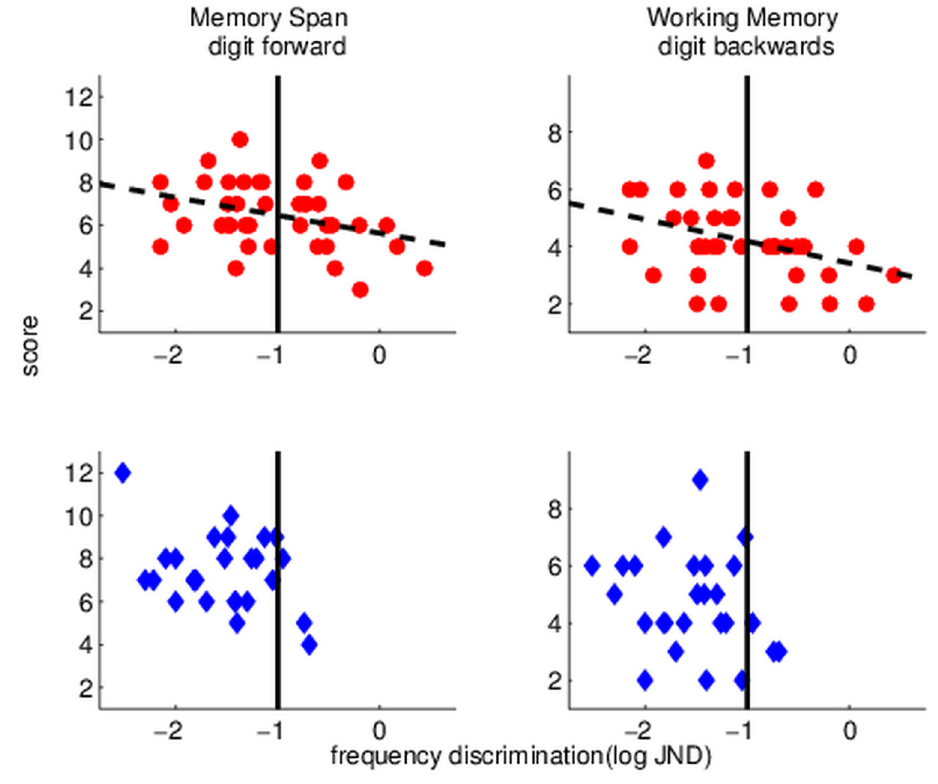
Figure 2. Scatter plots illustrating the relationships between frequency discrimination and two aspects of verbal memory, simple span (Digit forward; left column) and working memory span (Digit backward; right column) in musically naïve (top panels) and in musically experienced (more than a year; bottom panels) children. Dashed lines show the linear relationships between memory and frequency discrimination. Note that among musically trained children the JNDs of only 3/26 children were poorer than 10% (corresponding to a value of -1 in log units) whereas among musically naïve individuals 18/40 had these poor thresholds. In both groups these individuals tend to have poor memory